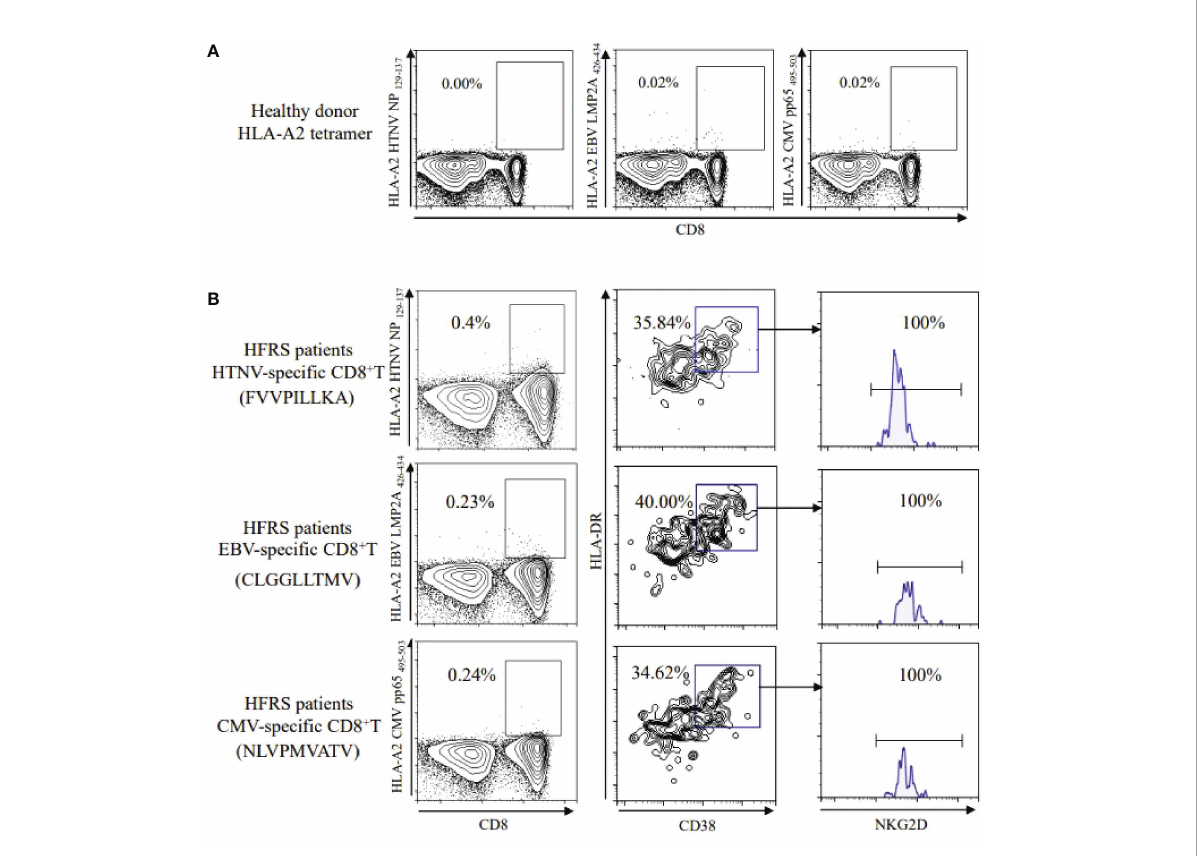
FIGURE 2 Detection of HTNV or other-virus speci fi c CD8 + T cells in healthy donors and in HFRS patients. (A) HTNV, EBV, or CMV-speci fi c CD8 + T cells in healthy donors. (B) Expression of NKG2D on CD38 + HLA-DR + CD8 + T cells speci fi c to HTNV, EBV, or CMV, respectively in HFRS